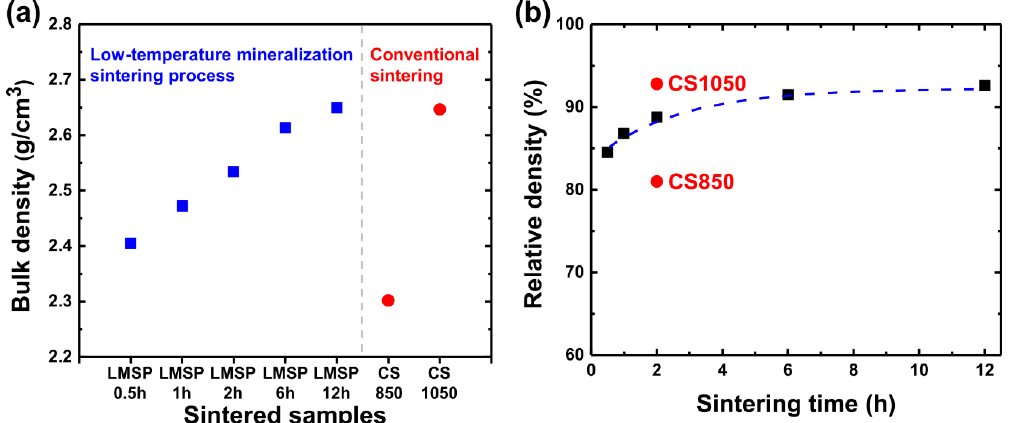
Figure 1. ( a ) Bulk density and ( b ) relative density against the sintering time of LMSP samples and cold sintering (CS) samples.